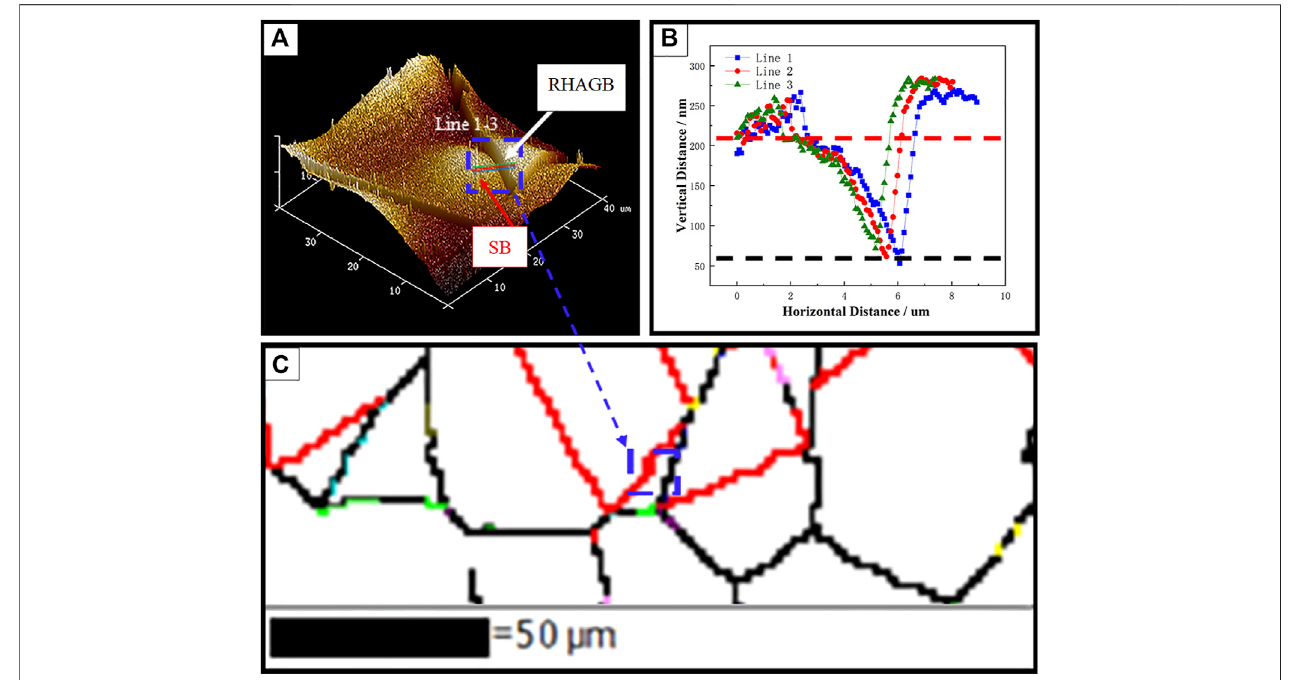
FIGURE 7 | Microstructure of the 316L ASS subjected to the intergranular corrosion: (A) AFM microstructure of the local area, (B) the corroded depth of the boundaries, and (C) the OIM map of GBCD.